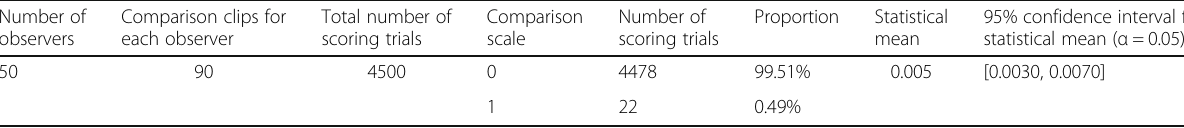
Table 5 The comparative subjective quality evaluation results Number of Comparison clips for observers each